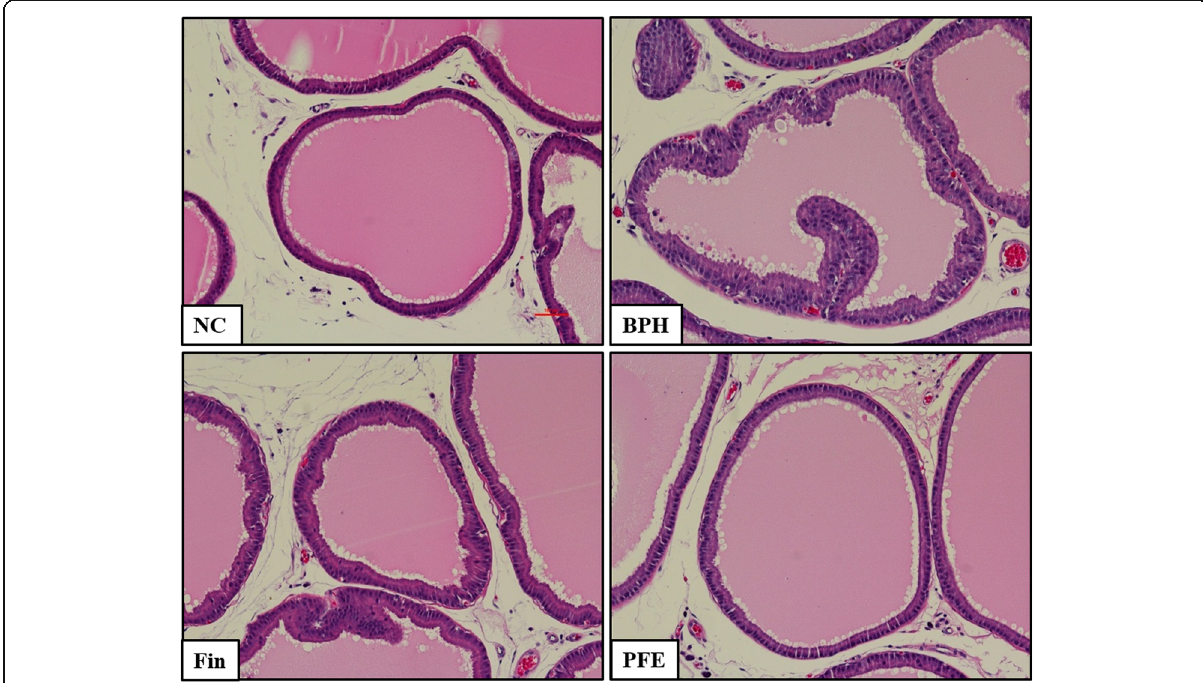
Fig. 5 Effect of PFE on the prostatic hyperplasia in TP-induced rats. Prostatic tissues were stained with a H&E solution for histological examination (magnification, 200×). Representative photomicrographs of prostate sections are shown. NC (normal control group), corn oil injection (s.c.) + PBS administration (p.o.); BPH (control group), TP (3 mg/kg)/corn oil injection (s.c.) + PBS administration (p.o.); Fin (positive control group), TP (3 mg/kg)/ corn oil injection (s.c.) + finasteride administration (10 mg/kg, p.o.); PFE (PFE-treated group), TP (3 mg/kg)/corn oil injection (s.c.) + PFE administration (200 mg/kg, p.o.). BPH, benign prostatic hyperplasia; Fin, finasteride; H&E, hematoxylin and eosin; PBS, phosphate-buffered saline; PFE, Ponciri fructus extract; p.o., peroral; s.c., subcutaneously; TP, testosterone